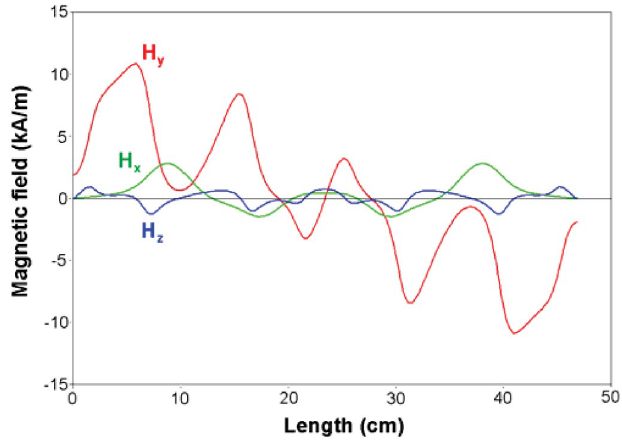
FIG. 6. (Color) Magnetic field.